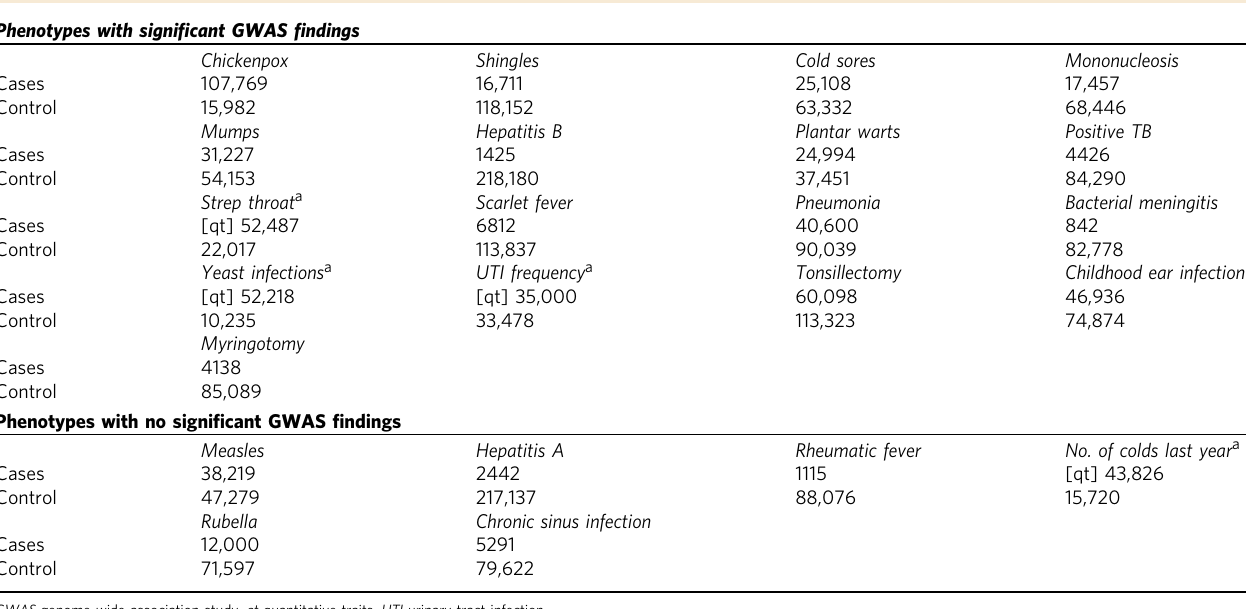
Table 1 Discovery cohort characteristics Phenotypes with signi fi cant GWAS fi